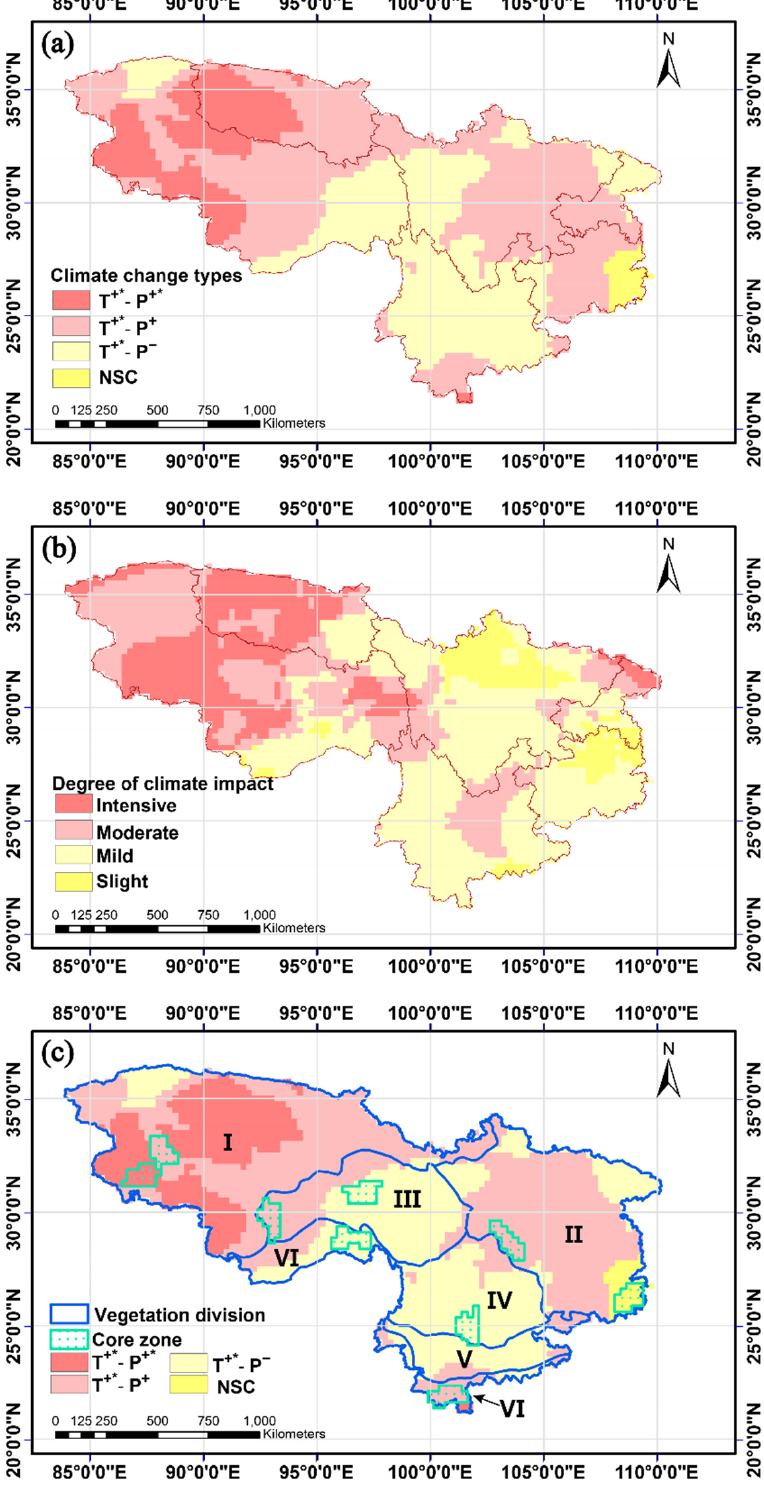
Figure 2. ( a ) Spatial distributions of climate change types, ( b ) the degree of climate impact and ( c